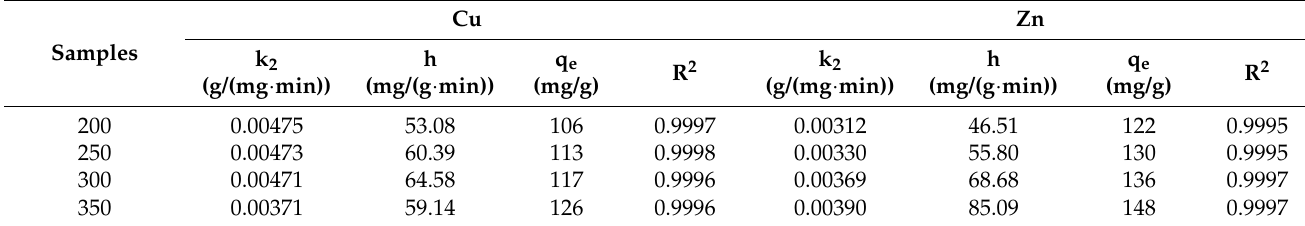
Table 1. Parameters of the pseudo − second order model.